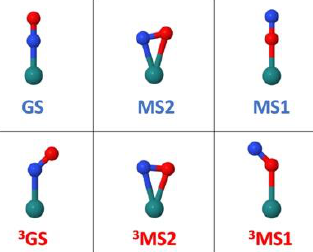
Figure 2. Illustration of the Ru–N–O geometrical arrangement in the singlet ground-state structures (GS, MS2, MS1) and in the triplet excited-states intermediates ( 3 GS, 3 MS2, 3 MS1). Color code: Ru in cyan, N in blue and O in red.